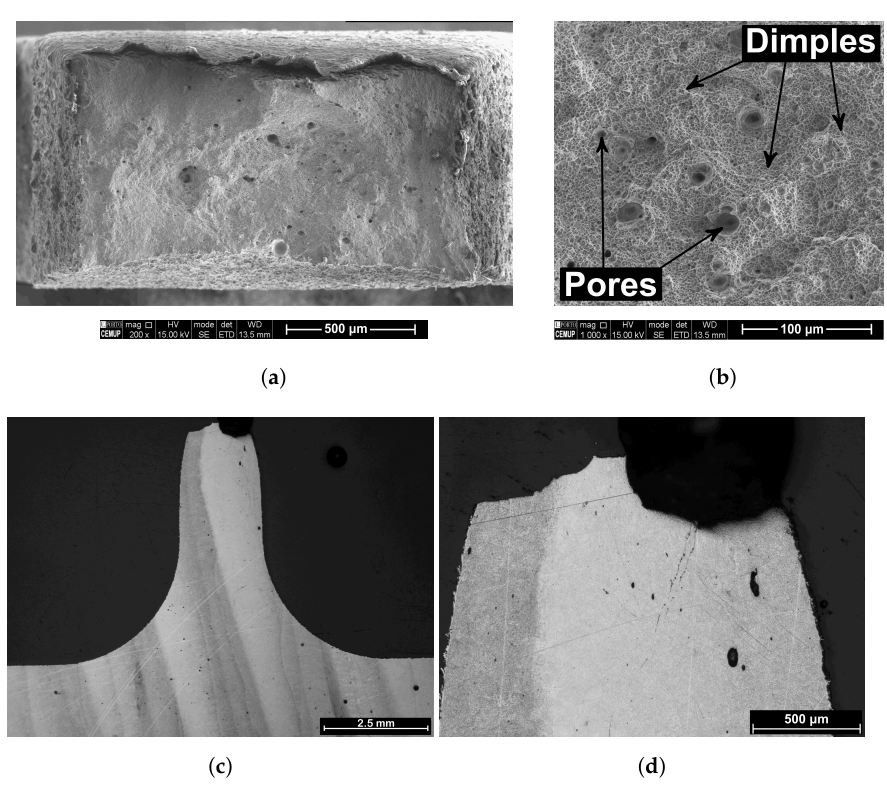
Figure 9. Horizontal specimen: SEM images of the: ( a ) fracture surface; ( b ) dimples and microporosi- ties observed; ( c , d ) optical microscopy images of the lateral side, etched